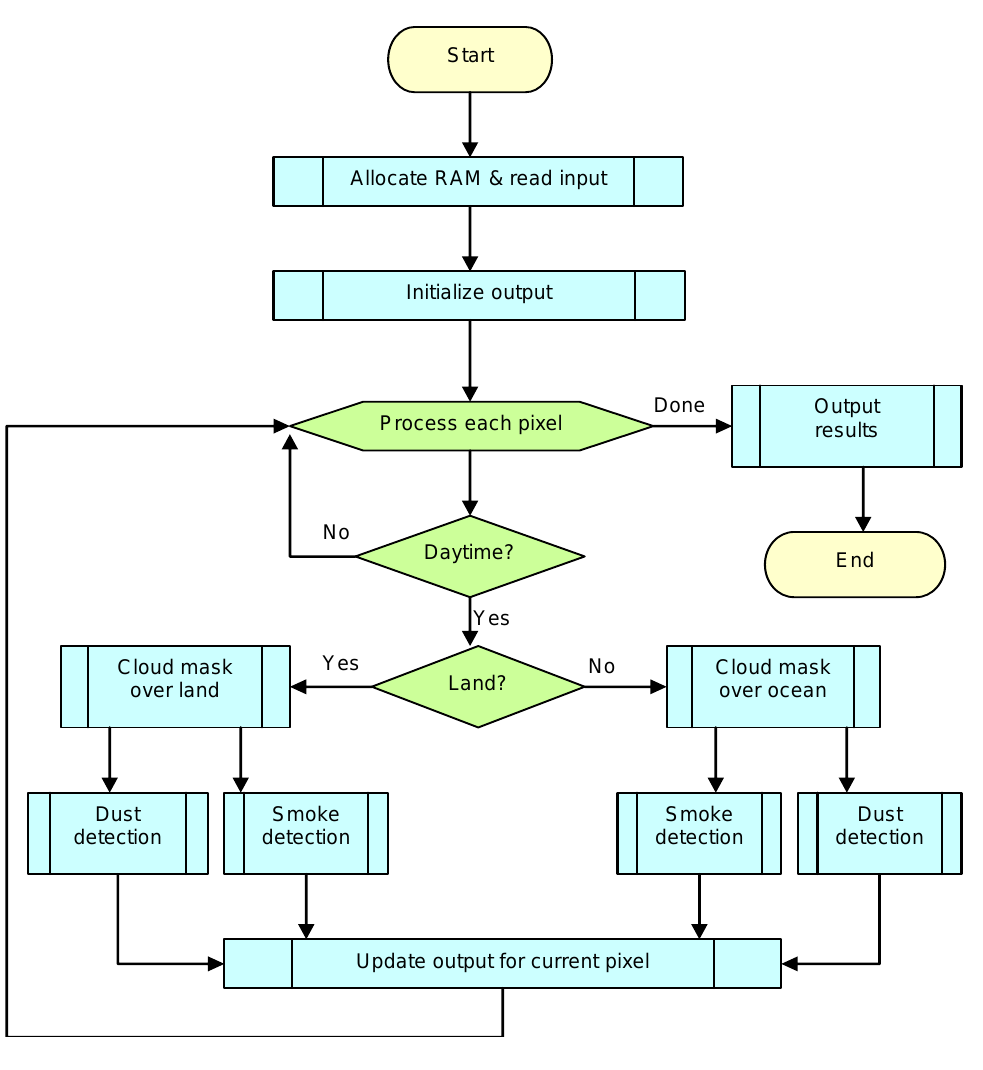
Figure 13. High level flowchart of the dust and smoke detection algorithms, illustrating the main processing